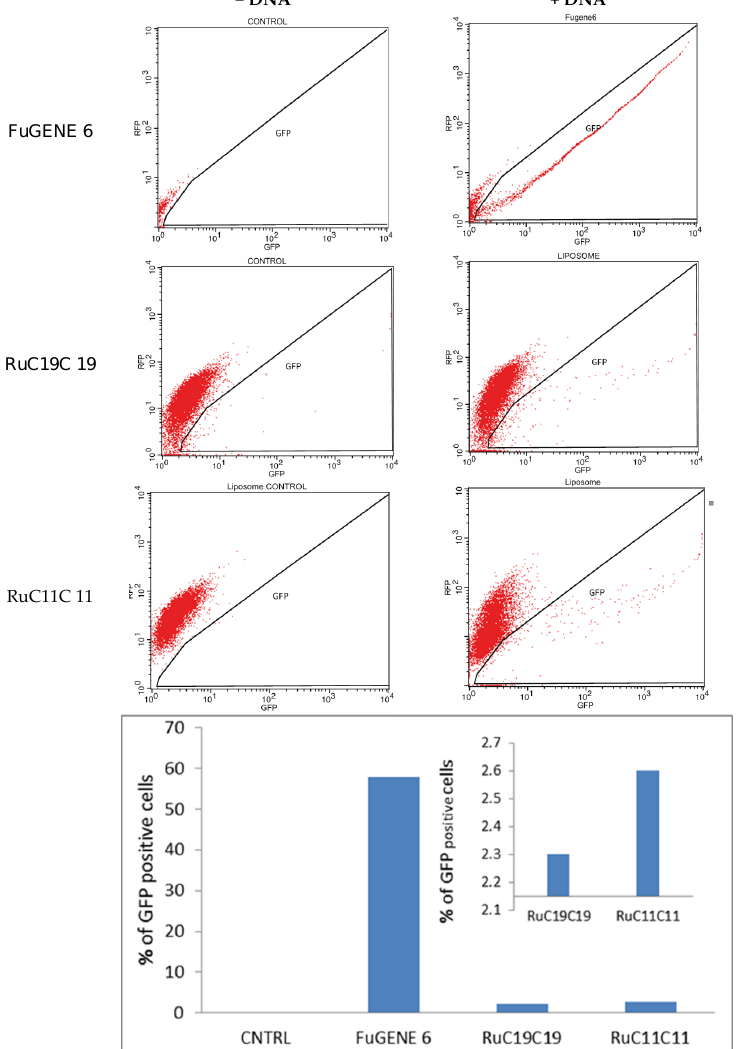
Figure 11. GFP expression of pEGFP-C1 in U2OS cells, using RuC11C11 and RuC19C19 liposomes at α = 0.2 and L/D = 20, sorted on the basis of fluorescence at 24 h, post-transfection. CNTRL represents the negative control. FuGENE 6 was used as a positive control.